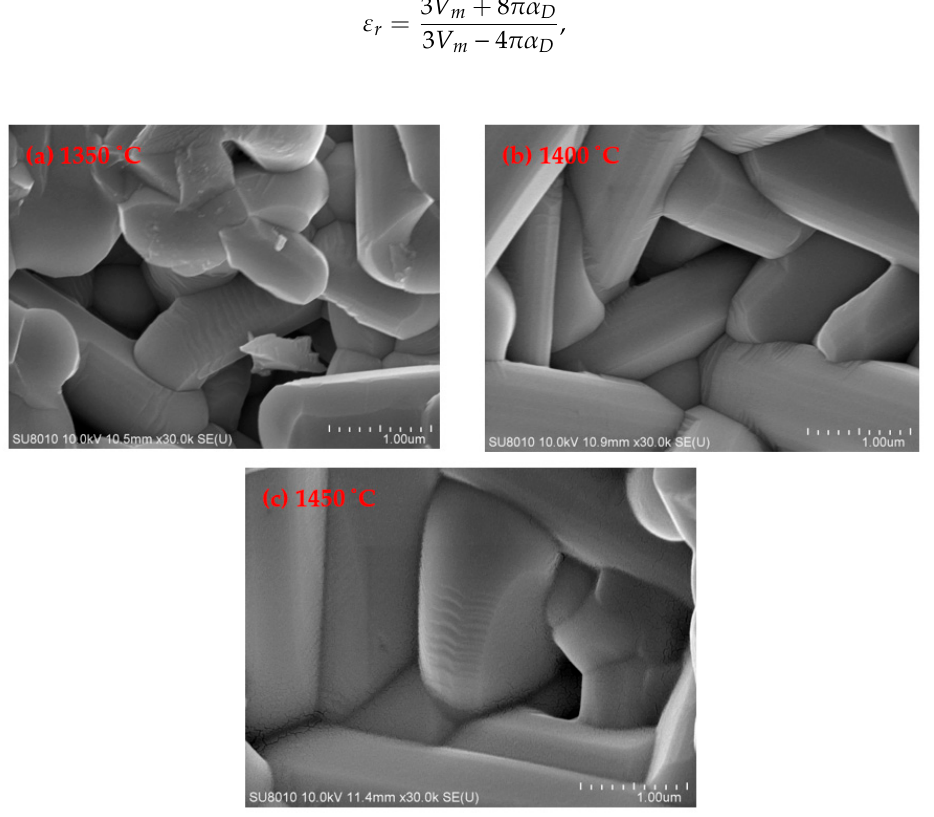
Figure 5. SEM morphologies of ceramics sintered at different temperature: ( a ) 1350 °C; ( b ) 1400 °C and ( c ) 1450 °C.